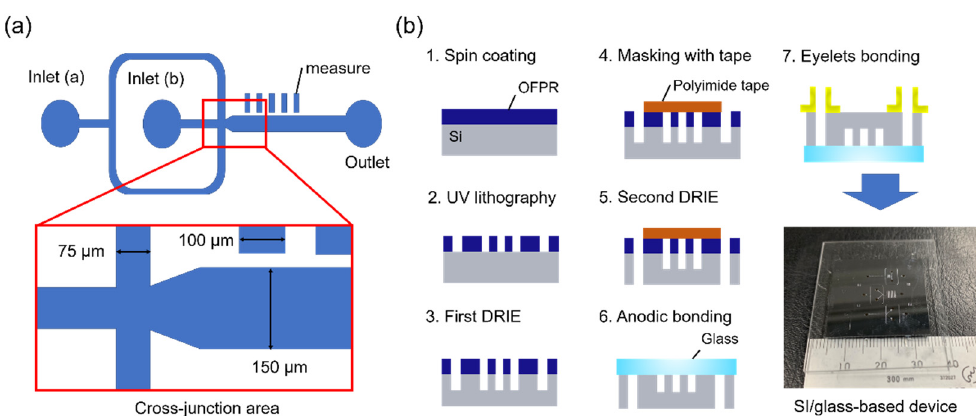
Figure 7. ( a ) Schematic diagram of channel design for the droplet generation device. The widths of the main channel and inlet channel were 150 and 75 µ m, respectively, and the channel depth was 100 µ m. ( b ) Fabrication process for the droplet generation device with a photograph of the silicon / glass-based device. The major / minor length of the device was about 4 / 3